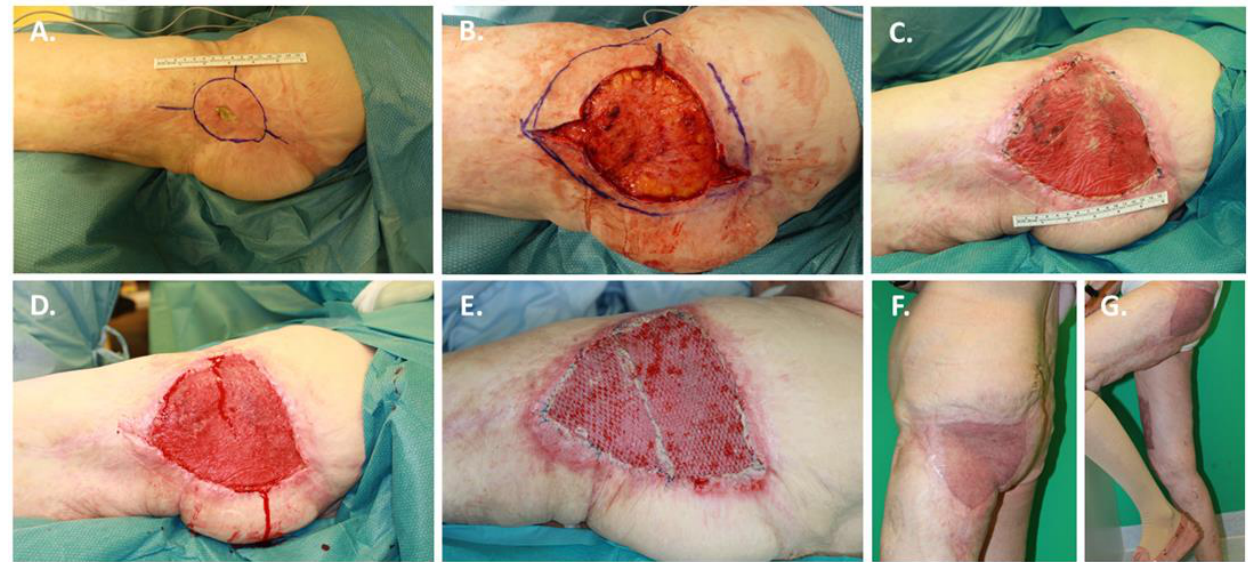
Figure 5. A case of an unstable scar after early childhood burn treated with BTM. A 79-year-old female was presented to us with an early childhood scald on the left buttock and thigh, which she had suffered at the age of 3 years: ( A ) Wound situation on admittance; ( B ) Wound situation for implantation of BTM; ( C ) Vascularized BTM after 21 days; ( D ) BTM after delamination; ( E ) Defini- tive defect coverage with autologous split-thickness skin grafting; ( F , G ) 3-month follow-up with appealing aesthetic and functional